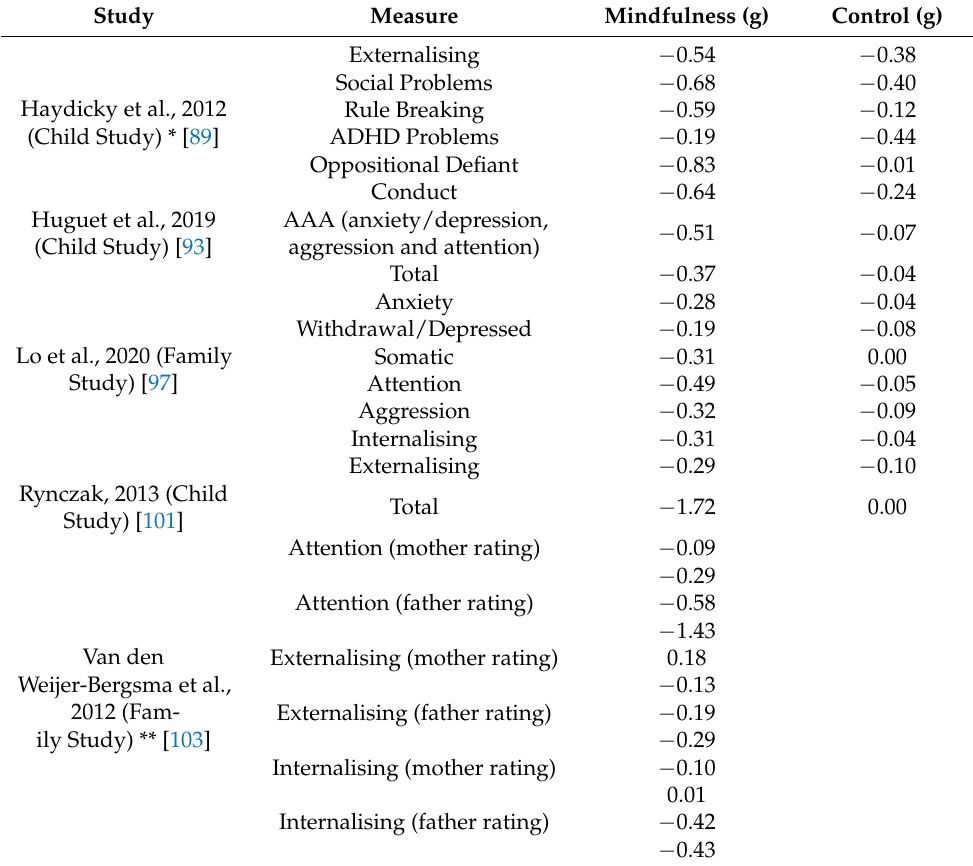
Table 8. Child Behaviour Check List (CBCL) effect sizes in child and family studies.